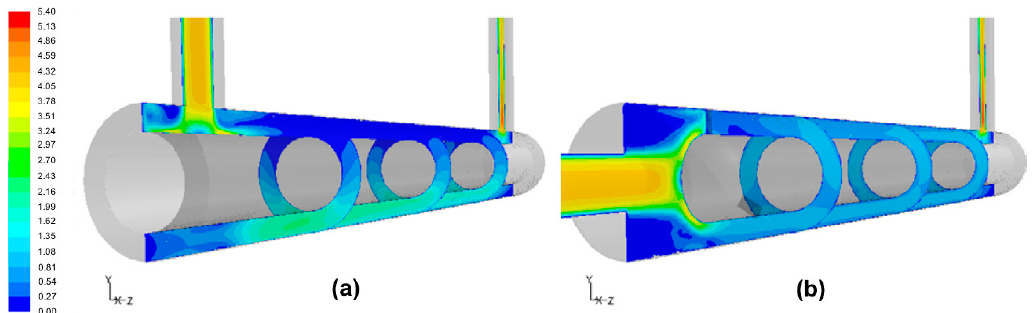
Figure 2. Contours of velocity magnitude (m/s) in: ( a ) U-shape; and ( b ) L-shape annular reactor calculated using the R k– ε model. Reprinted with permission from [45]. Copyright Elsevier, 2009.